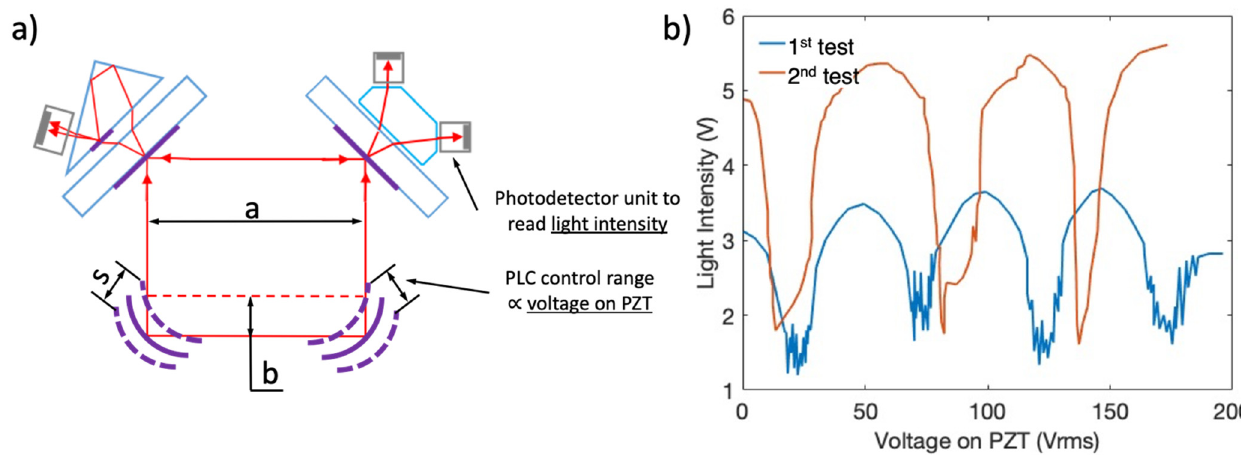
Figure 7. ( a ) Mode-scanning test schematic of a 4-mirror laser oscillator where the initial path is a square of pathlength, (4a) which changes to (4a–2b) after a linear perturbation, (s/2) of 2 PLCs; ( b ) figure shows the fluctuations of the light intensity as a function of PZT voltage.